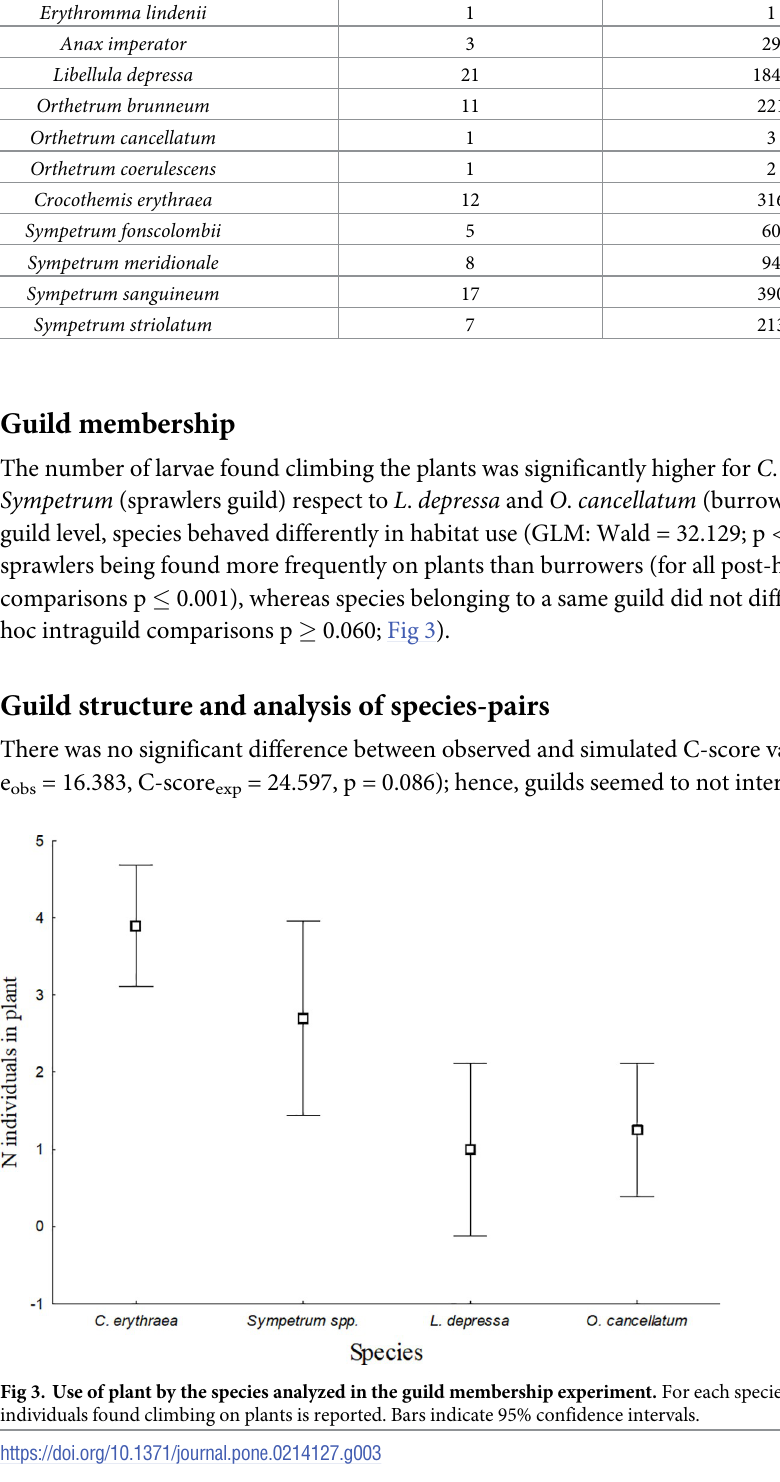
PLOS ONE | https://doi.org/10.1371/journal.pone.0214127 June 21,